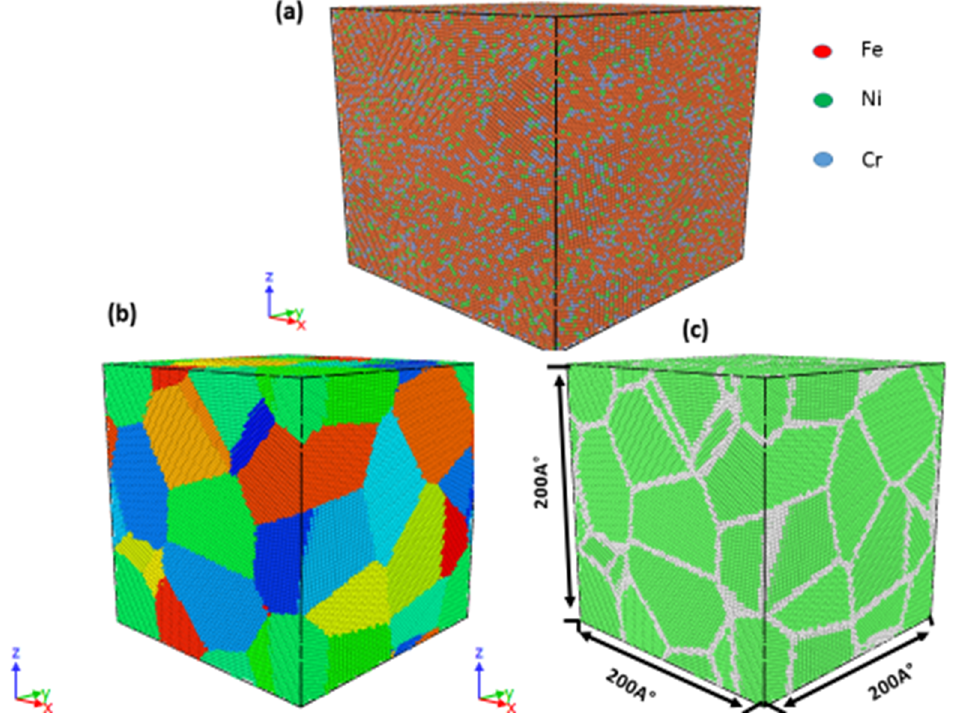
Figure 1. 3D atomic configuration of nanocrystalline 316L stainless steel with an average grain size of 2.5 nm. ( a ) Atomic composition, ( b ) grain identity number, and ( c ) common neighbor analysis. Green atoms indicate fcc structures, blue atoms indicate bcc structures, red atoms indicate hexagonal close-packed (hcp) structures, and white atoms indicate other lattice structures.